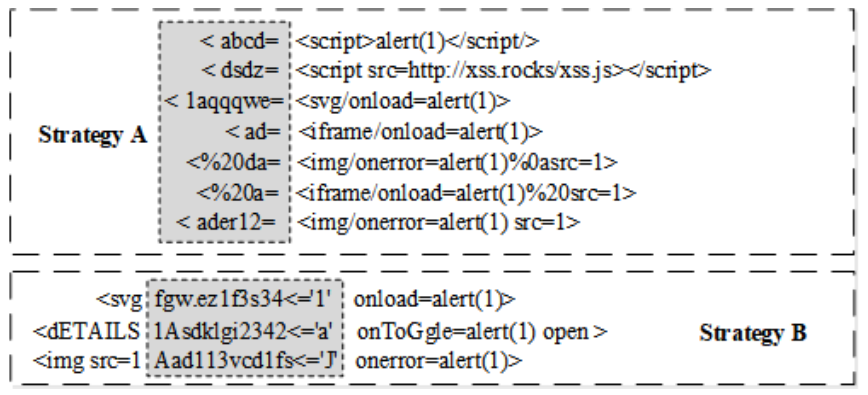
Figure 6. Examples of generic XSS escape strategies for XSSChop.